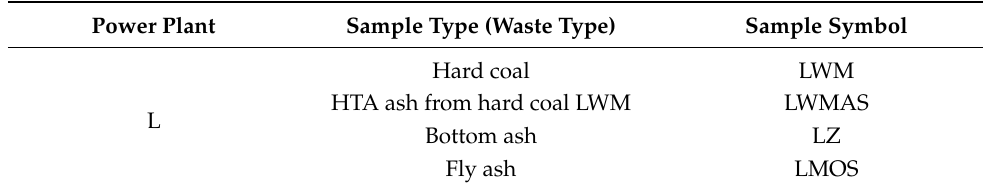
Table 1. List of examined samples. Power Plant Sample Type (Waste